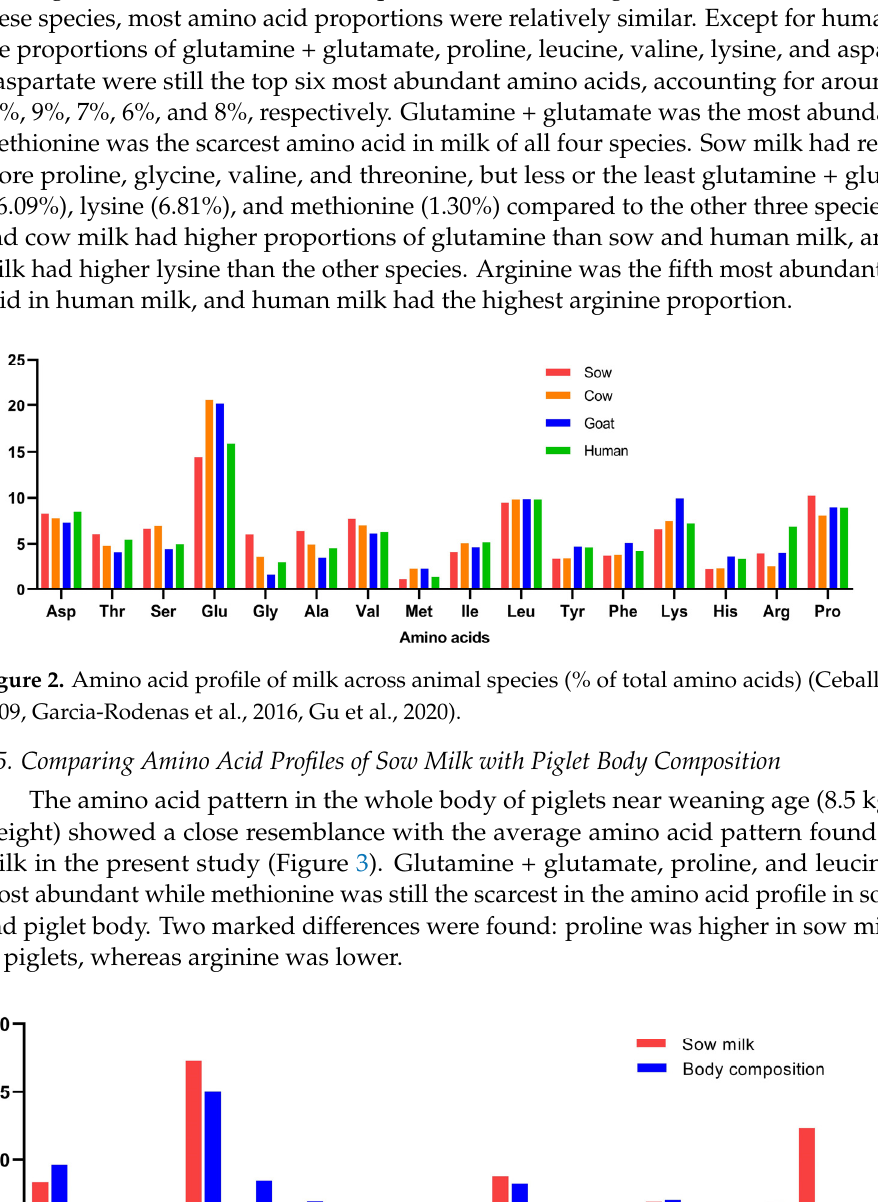
Figure 1. Amino acid pro fi le of sow milk across studies (% of total amino acids, the black spot were